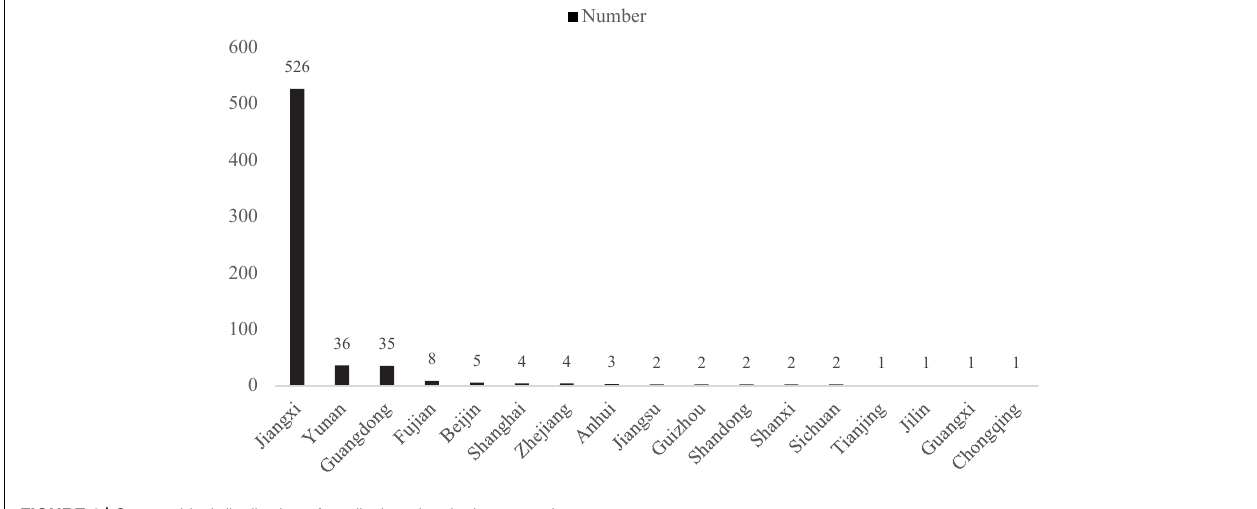
FIGURE 1 | Geographical distribution of medical student in the research.